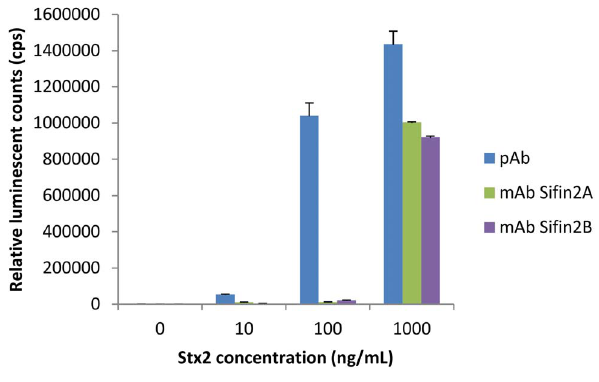
Figure 4. Comparison of antigen binding capacity between pAb derived from RB 5154 and commercially available mAbs, Sifin2A and Sifin2B. Coating antigen (Stx2a) was diluted in PBS at concentrations indicated. Primary antibodies (pAb or mAb) were used at 1 m g/mL and secondary antibodies (goat anti-rabbit or goat anti- mouse IgG) conjugated with HRP were used at 1:5,000. Each bar represents the mean of three independent repeats performed in duplicates.